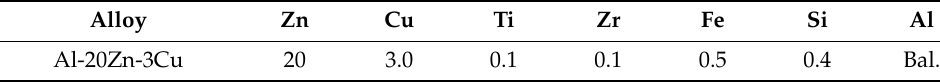
Table 1. Chemical compositions of Al-20Zn-3Cu alloys (in wt%). Alloy Zn Cu